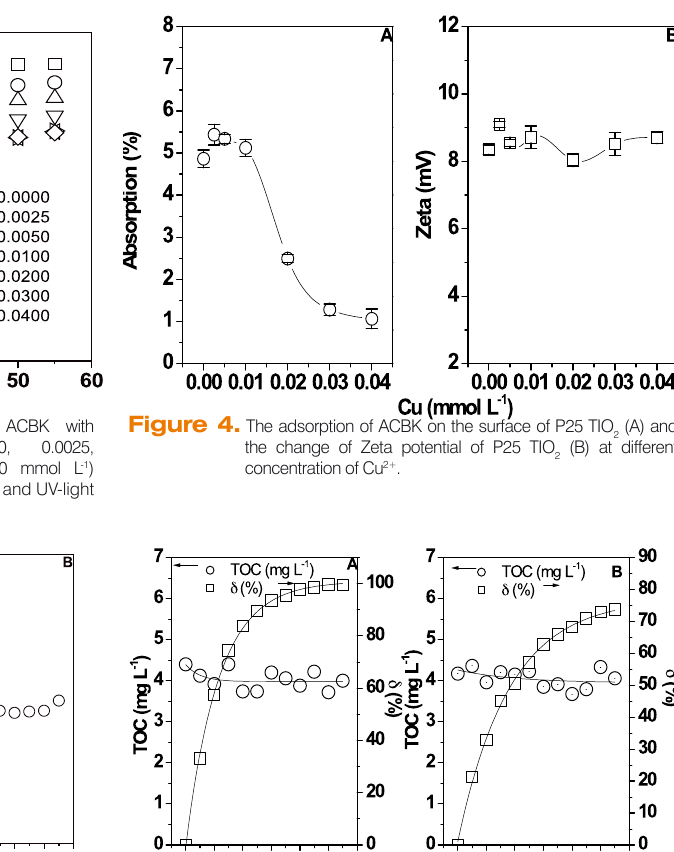
Figure 2. Spectral change of 0.050 mmol L -1 ACBK (A) and 0.050 mmol L -1 ACBK with 0.0100, 0.0200 and 0.0300 mmol L -1 Cu 2+ (B, C and D) at pH 5.0 buffer solutions with 0.05% P25 TIO and UV-light at given time intervals. Spectra from 1 to 12 denote irradiation times from 0 to 2 55 min with 5 min intervals